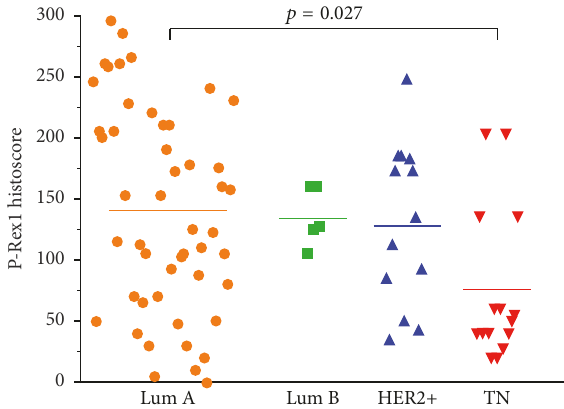
Figure 1: P-Rex1 expression in primary breast tumors. P-Rex1 is highly expressed in luminal (Lum) compared to triple-negative (TN) breast cancers. Each point represents mean P-Rex1 histoscore from two pathologists. Horizontal bars indicate mean histoscore for each receptor subtype. Data were analyzed by ANOVA followed by Tukey’s HSD post hoc testing between